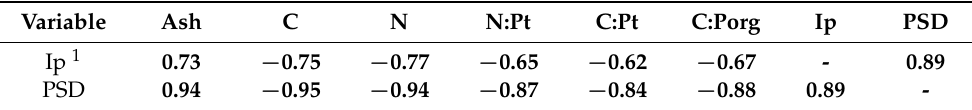
Table 7. Correlation coefficients for Ip and PSD indicators and Ash, C, N and N:P, C:P ratios. Correlation coefficients significant at p < 0.05 are shown in